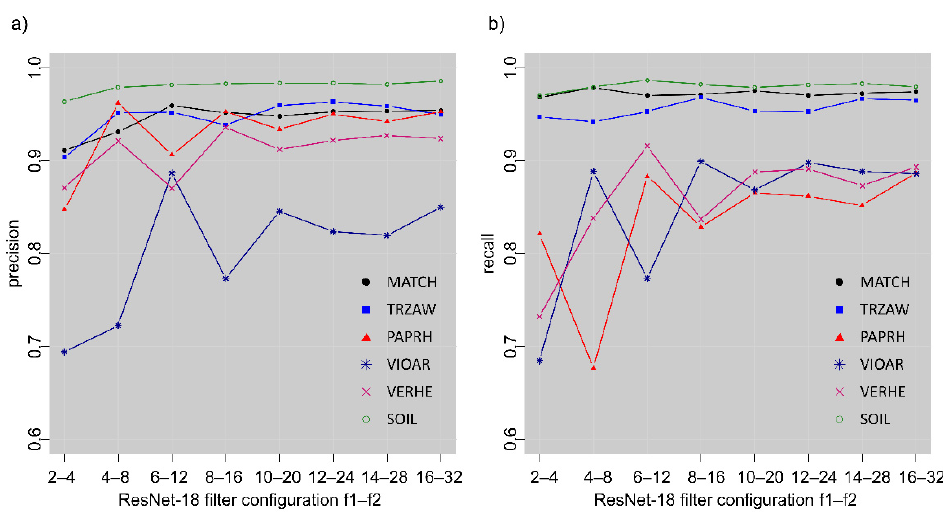
Figure 8. Class specific precision ( a ) and recall ( b ) model performance on the test set in relation with filter configuration. Model results for each filter configuration were aggregated from five model runs with different randomization (seeds) of the weights. Table 3. Confusion matrix for the evaluation on the test set for the image-level classifier using the ResNet-18 model with filter configuration 10(20). The resulting counts were agglomerated from five random seeds by median. CV refers to the coefficient of variation computed from the different outcomes of recall or precision expressed in